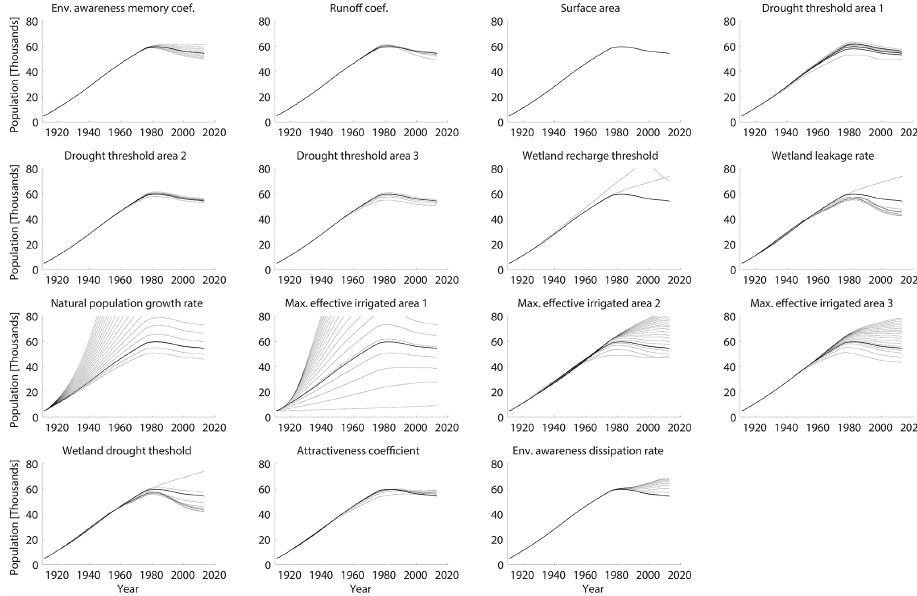
Figure 12. Modeled time series of total population for different values of the tested parameters. All subplots correspond to one tested parameter, the separate lines represent model outcome for a given